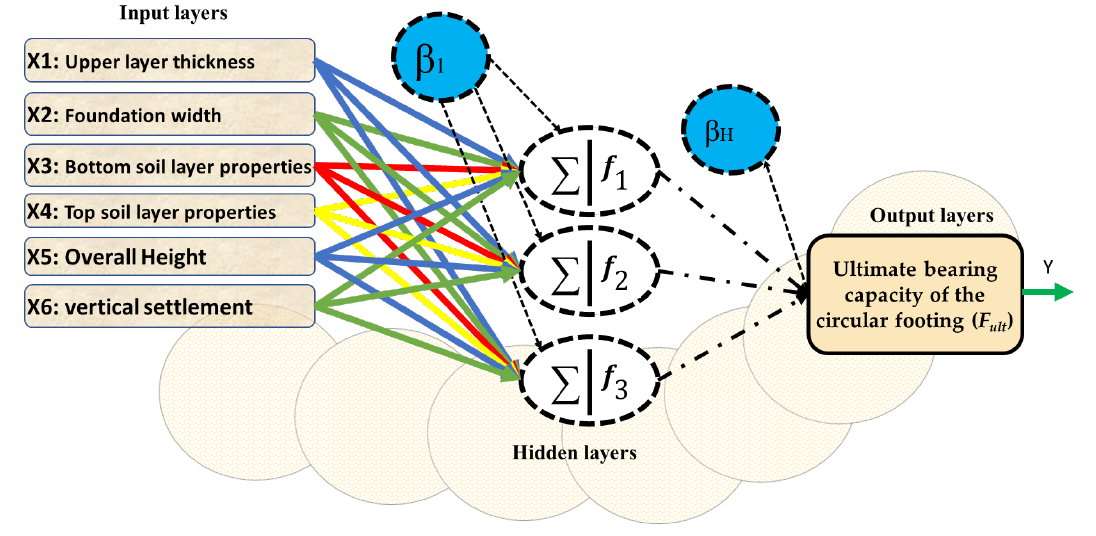
Figure 1. Flowchart of the ANN model.